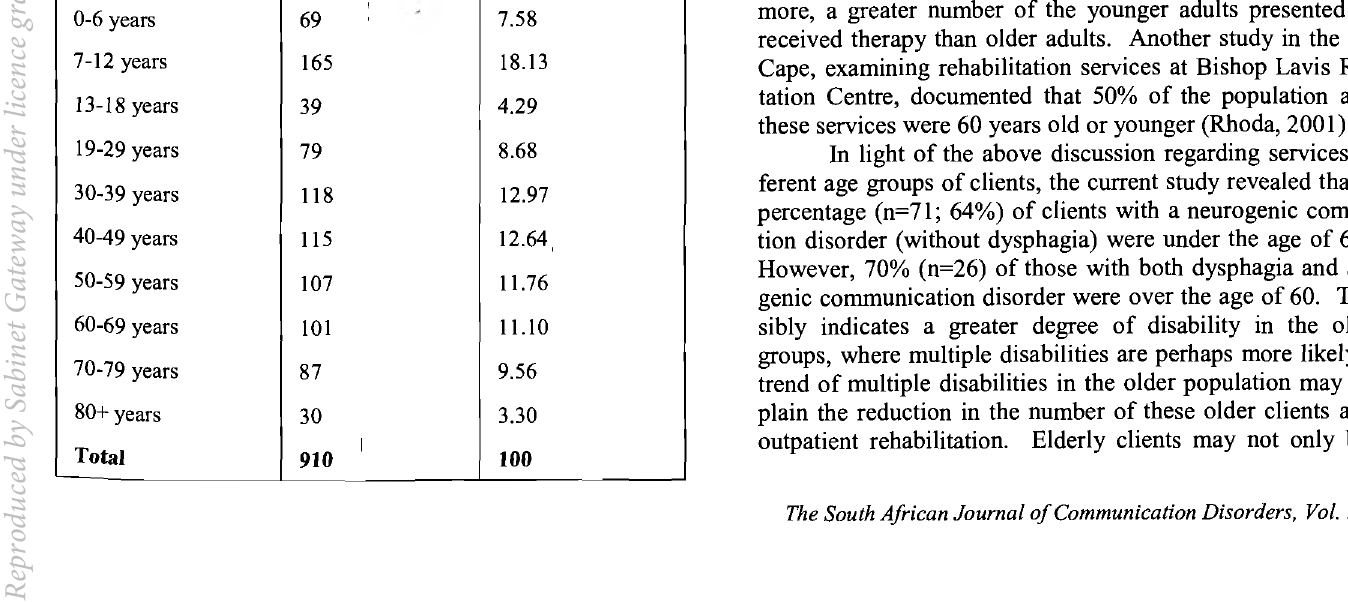
Table 1: Number and percentage of clients per age group who attended the Speech-Language Therapy and Audiology OPD at a tertiary hospital in the Western Cape from